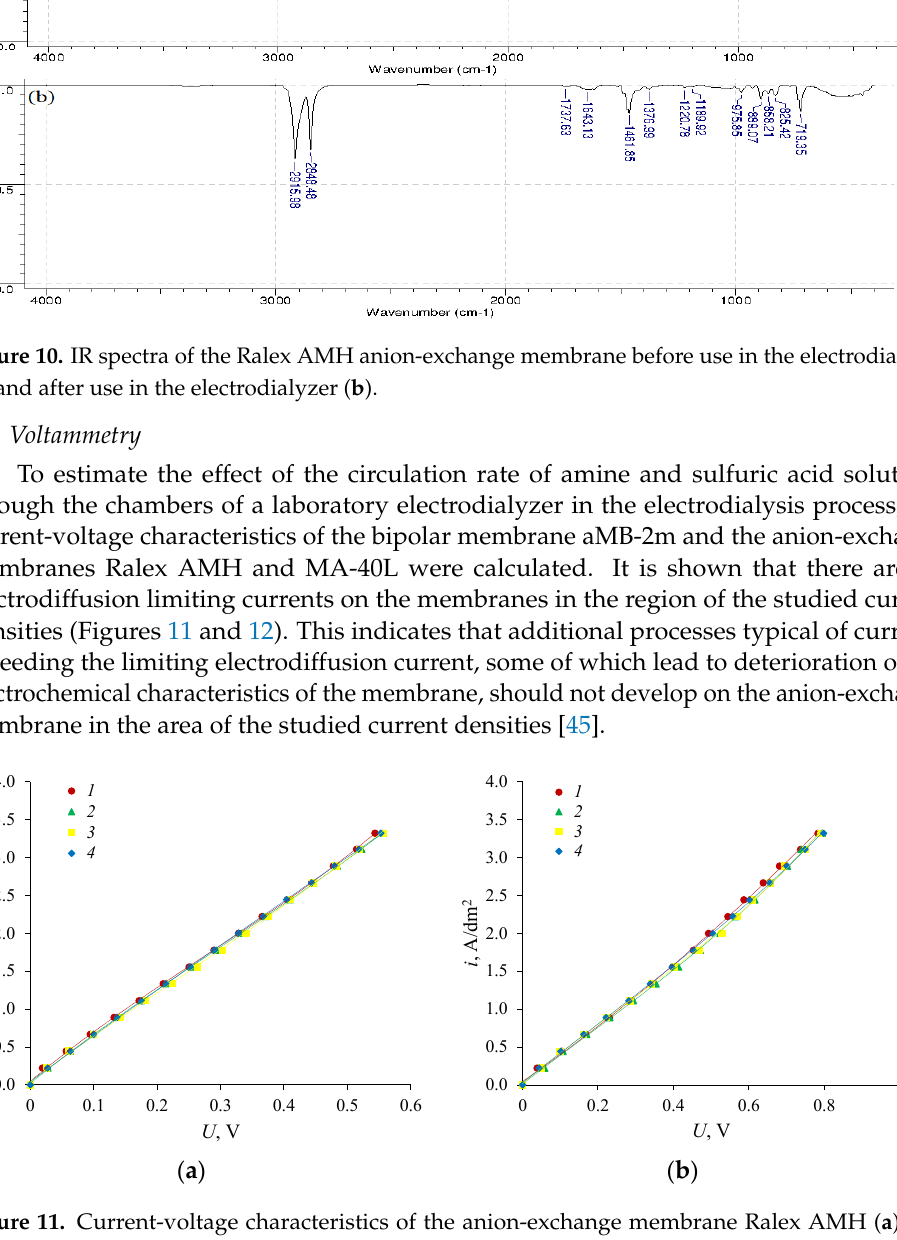
Figure 12. Current-voltage characteristics of the aMB-2m bipolar membrane at different speeds of circulation of solutions: For initial membrane: 1 —2.5 cm/s, for membrane after use in electrodialysis processes: 2 —0.5 cm/s, 3 —1.5 cm/s, 4 —2.5 cm/s. Each curve was calculated by averaging over the overvoltage of three-time measurements of current-voltage characteristics. It is shown that the circulation rate of solutions adjacent to the anion-exchange membranes under study almost does not affect their current-voltage characteristics. This is due to the fact that the used current densities are significantly lower than the limiting electrodiffusion current (there is no “plateau” of the limiting current) on the membrane. The rate of solutions circulation adjacent to the ion-exchange membranes under study mainly affects the value of the limiting electrodiffusion current and very weakly affects the slope of the current-voltage characteristics of the membranes. The analysis of the dependencies shows that the circulation rate of solutions does not affect the current-voltage characteristics of bipolar membranes. However, it can be noted that at the same solution speed (2.5 cm/s), the current-voltage characteristics of the bipolar membranes before use in electrodialysis processes for the production of amines (1) and the membranes that were used in electrodialysis processes (2, 3, 4) are markedly different. For bipolar membranes used in amine production processes, there is a decrease in voltage drop compared to the original membranes. This may be due to the breaking of the polyethylene interlayers in the bipolar region during the use of the membrane in the